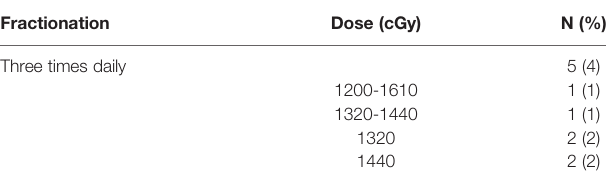
TABLE 5 | Risk factors for pulmonary toxicity and